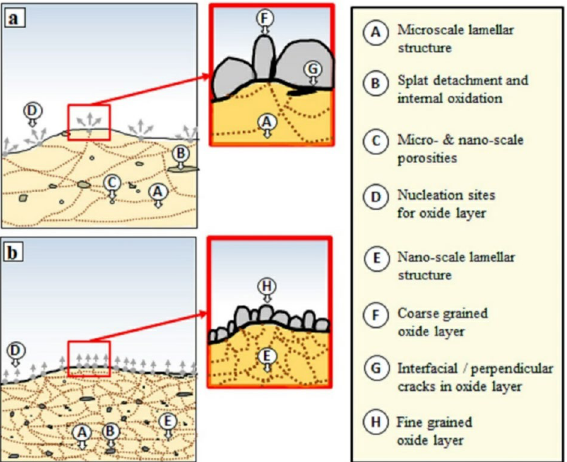
Figure 20. Schematic of the nucleation and growth of the oxide layer for the ( a ) conventional and ( b ) nanocrystalline MCrAlY